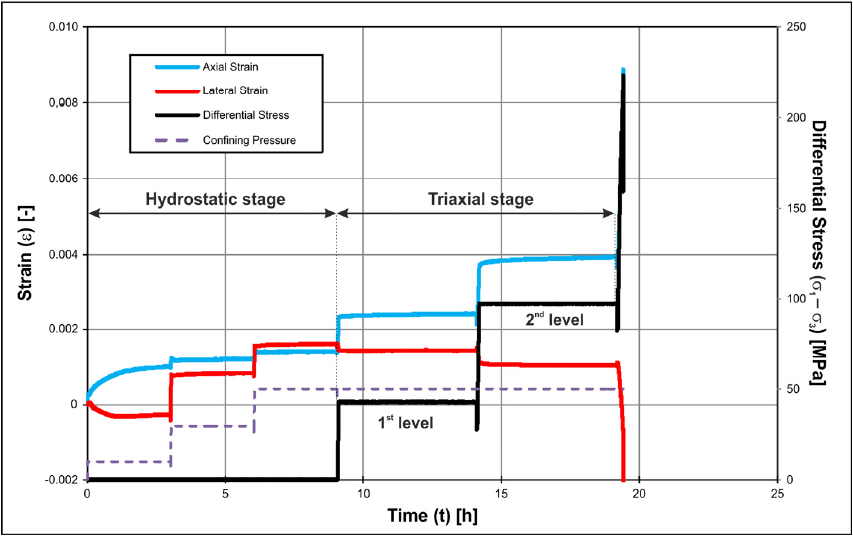
Figure 11. Relationship of axial strain, lateral strain, differential stress and confining pressure and time in viscoelastic creep tests for sample M-43-B. Table 3. Conditions of the performed studies and obtained results during viscoelastic creep tests for all analysed samples from the analysed claystone units.